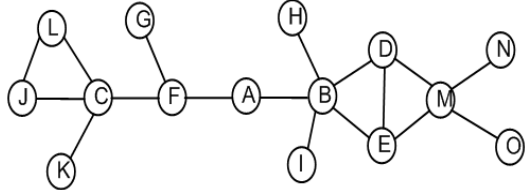
Figure 2. Graphic representation of a connected inter-actor